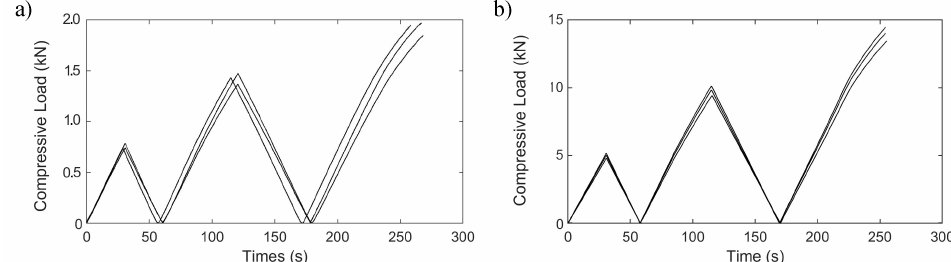
Figure 11. Compressive load profiles: experimental and FEM results for chiral elements of ( a ) 0.8 mm thickness, ( b ) 1.6 mm